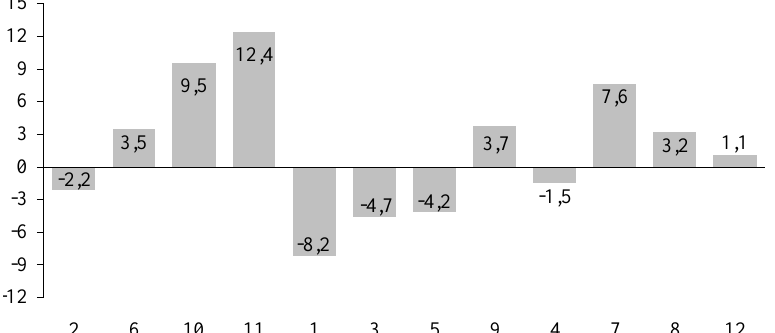
Figura 3. Diferenças percentuais entre os valores de escoamento superficial (ES), obtidos experimentalmente e calculados com o modelo desenvolvido por Pruski et al. (1997). Valores negativos são referentes aos testes nos quais os valores experimentais superaram os valores calculados com o modelo e os valores positivos correspondem àqueles nos quais o modelo superou os valores obtidos